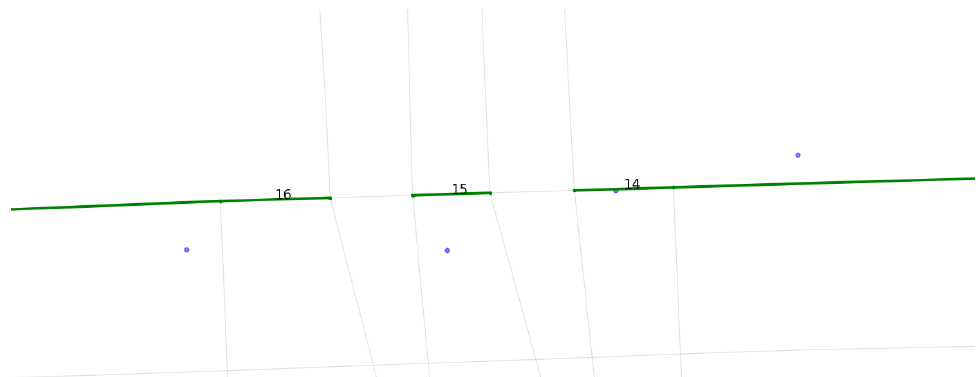
Figure 4. Cat-III error : discontinuity in the route.